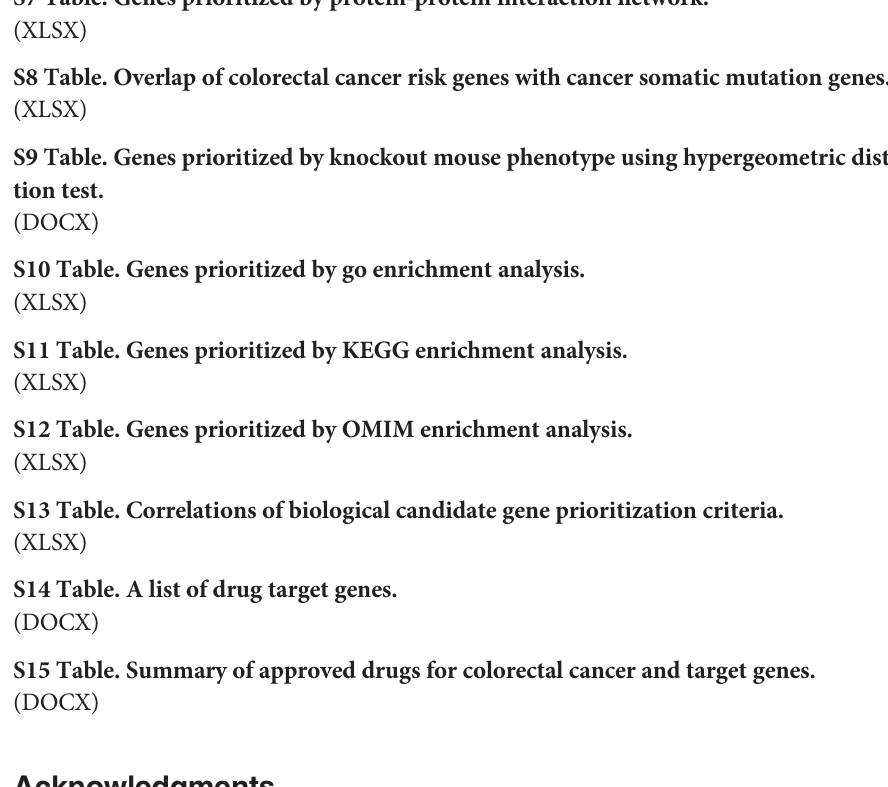
S6 Table. Genes prioritized by PubMed text mining. S7 Table. Genes prioritized by protein-protein interaction network. S8 Table. Overlap of colorectal cancer risk genes with cancer somatic mutation genes. S9 Table. Genes prioritized by knockout mouse phenotype using hypergeometric distribu- tion test. S10 Table. Genes prioritized by go enrichment analysis. S11 Table. Genes prioritized by KEGG enrichment analysis. S12 Table. Genes prioritized by OMIM enrichment analysis. S13 Table. Correlations of biological candidate gene prioritization criteria. S14 Table. A list of drug target genes. S15 Table. Summary of approved drugs for colorectal cancer and target genes.